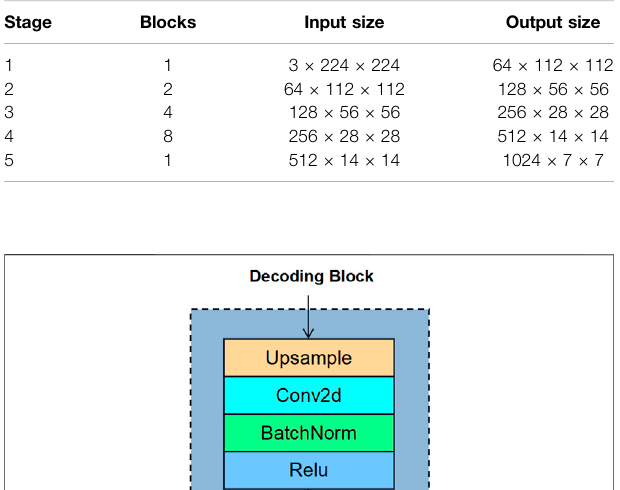
TABLE 1 | Encoder parameters of each stage. The fi rst parameter of the size indicates the number of channels, and the last two parameters indicate the size of the image during the down-sampling process.